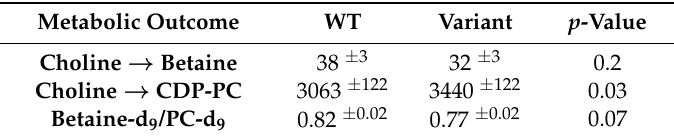
Table 9. BHMT rs3733890 genotype alters plasma choline metabolite partitioning and flux. Values are least-squared means ± standard errors for each group. Betaine-d9/PC-d9 values are ratios, choline → betaine values are in µ M betaine/study period and choline → CDP-PC values are in µ M PC/study period.